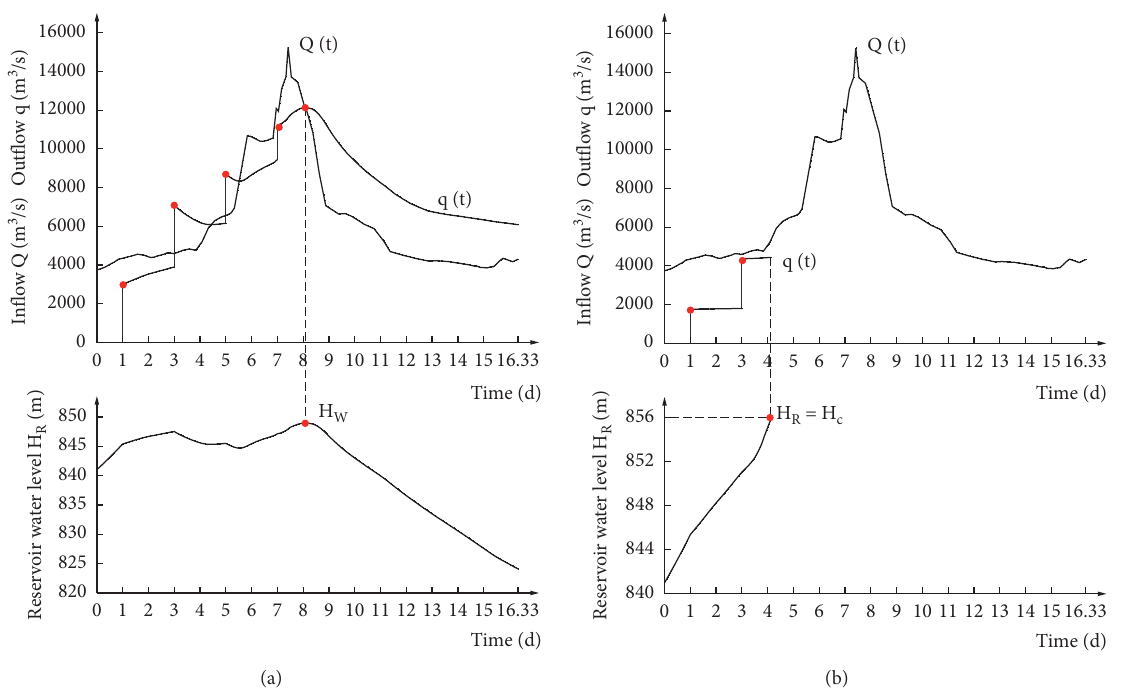
Figure 10: Typical results of reservoir routing for the PBG